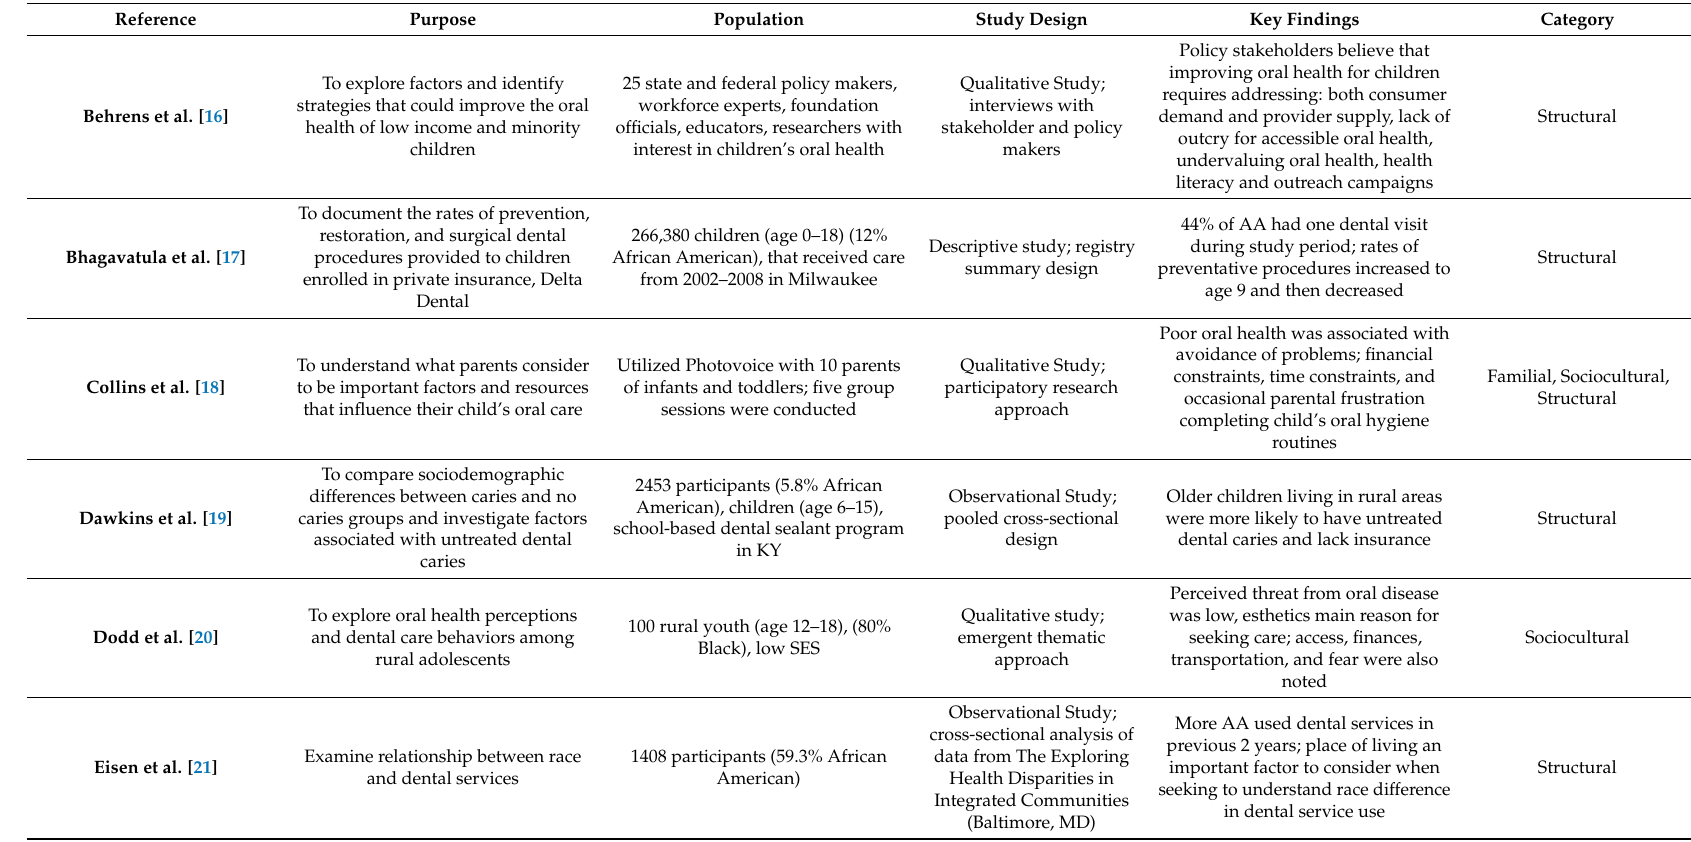
Table 1. Articles that describe oral health barriers African American families